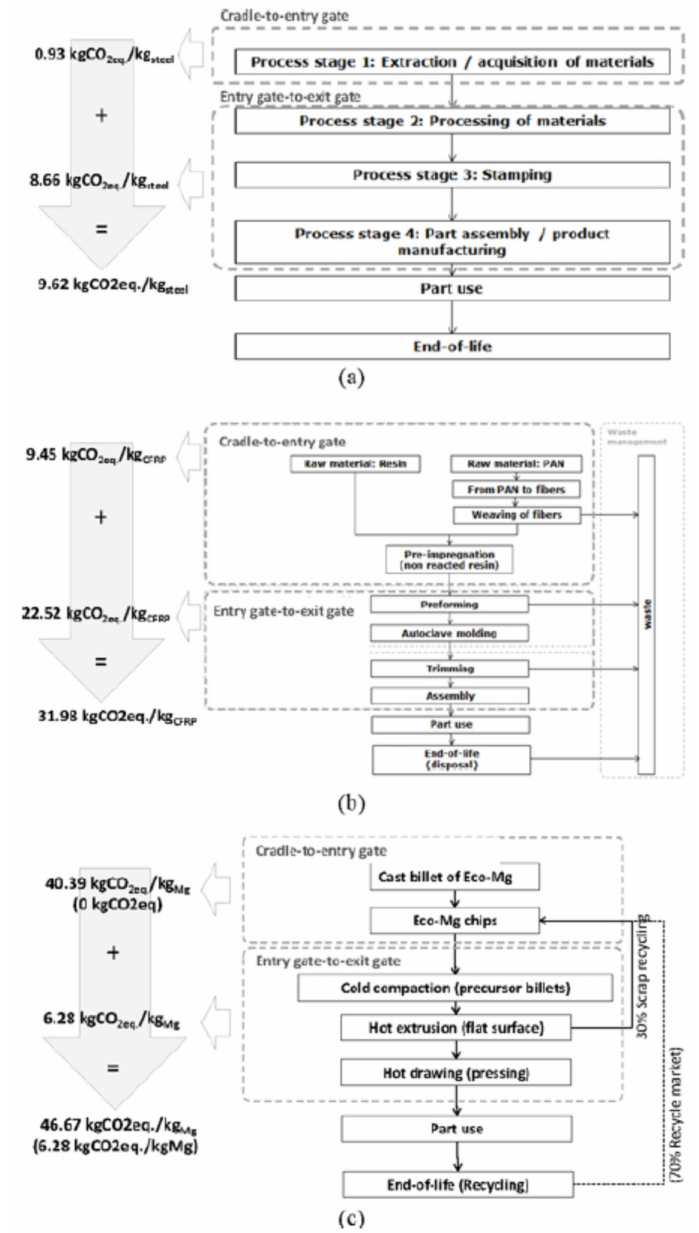
Figure 11. Process cycles and GWP results by Carbon Calculation over the Life Cycle (CCalC) software calculation: ( a ) LCA of conventional steel floor pan; ( b ) LCA of CFRP floor pan; ( c ) LCA for novel process route of extrusion of in-situ recycled Ecochips mixed with: (i) 70% of fresh material provided (cast billet and ecochips pathway); (ii) (in parenthesis) 70% of raw material entirely provided by recycling market. Reprinted from [65], © 2020 with permission from Springer